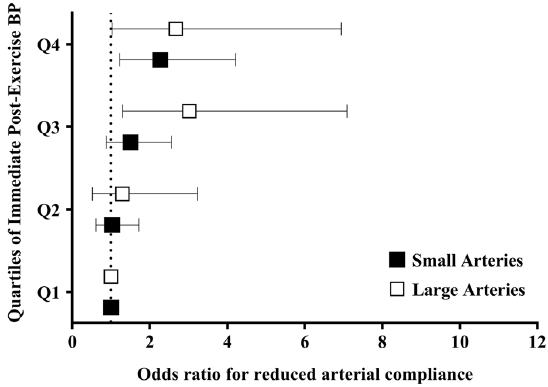
Figure 1. Odds ratio for reduced small and large arterial compliance according to quartiles of immediate post- exercise systolic blood pressure (n = 548). Quartile 1 (Q1): immediate post-exercise systolic BP ≤ 140 mmHg; Quartile 2 (Q2): immediate post-exercise systolic BP 141-153 mmHg; Quartile 3 (Q3): `–164; Quartile 4 (Q4): immediate post-exercise systolic BP ≥ 165 mmHg. * Different from Q1 (p < 0.05). a Analysis adjusted for body mass index, resting systolic blood pressure, total cholesterol, 6-minute walking test, frailty status, and smoking. Goodness of fit of the model: p < 0.001 in Omnibus test and p = 0.837 in Hosmer-Lemeshow test. b Analysis adjusted for age, body mass index, and resting systolic blood pressure. Goodness of fit of the model: p < 0.001 in Omnibus test and p = 0.344 in Hosmer-Lemeshow test.